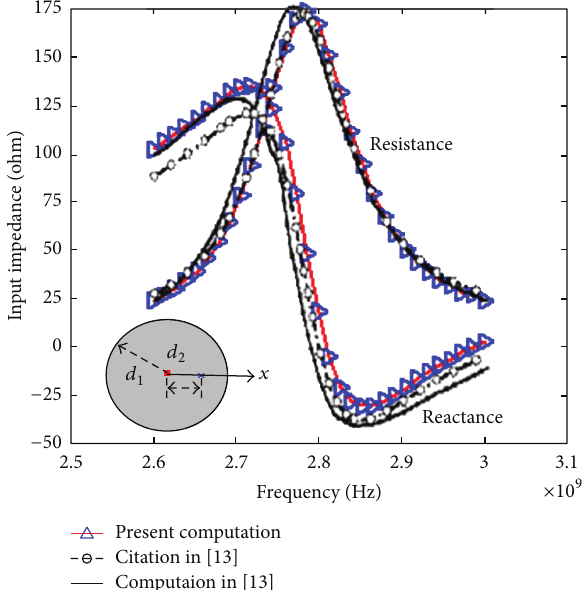
Figure 10: The comparison between the calculated result in this paper and the one of reference